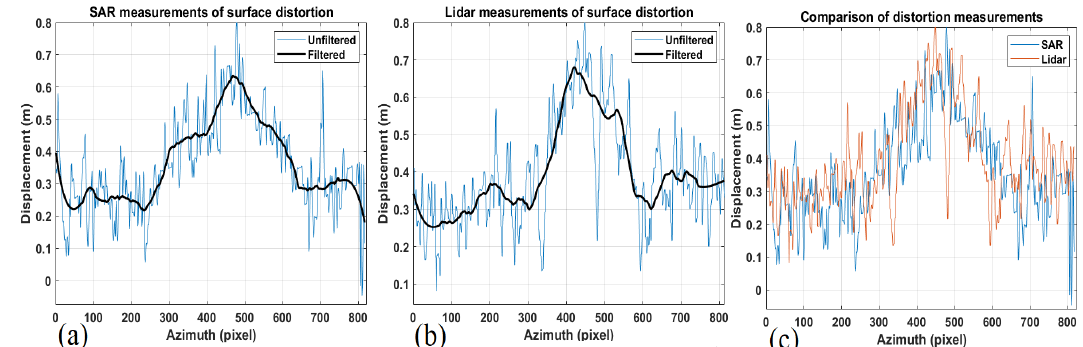
Figure 19. Representation in particular of the pyramid of Menkaure. Interferometric phases. ( a ): Menkaure pyramid. ( b ): east side interferometric fringe particular. ( c ): west side interfero- metric fringe particular. ( d ): north side interferometric fringe particular.